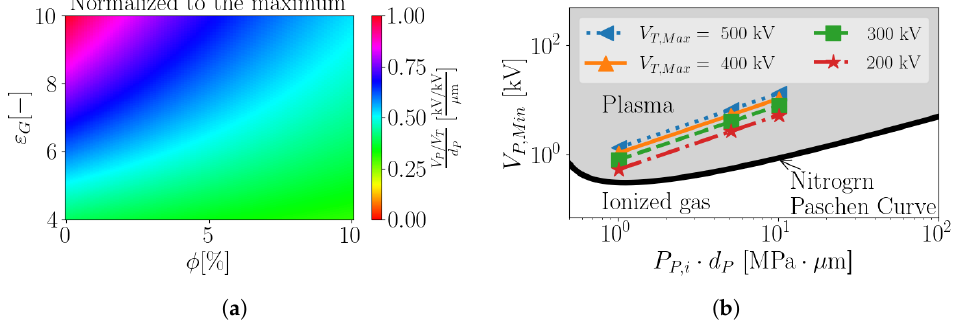
Figure 6. ( a ) The relative pore voltage as a function of rock porosity, φ , and the rock grain relative permittivity, ε G , for a given electrode gap distance of d E = 20 mm. ( b ) Comparison of the Nitrogen Paschen Curve, and the maximum pore voltage drops, calculated for different maximum pulse voltage drops, V T , Max